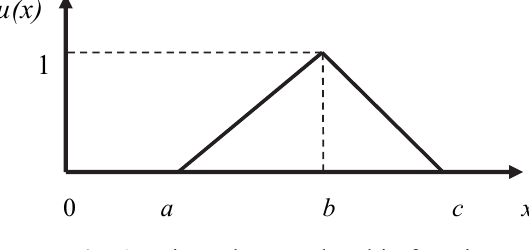
Fig. 1. Triangular membership function